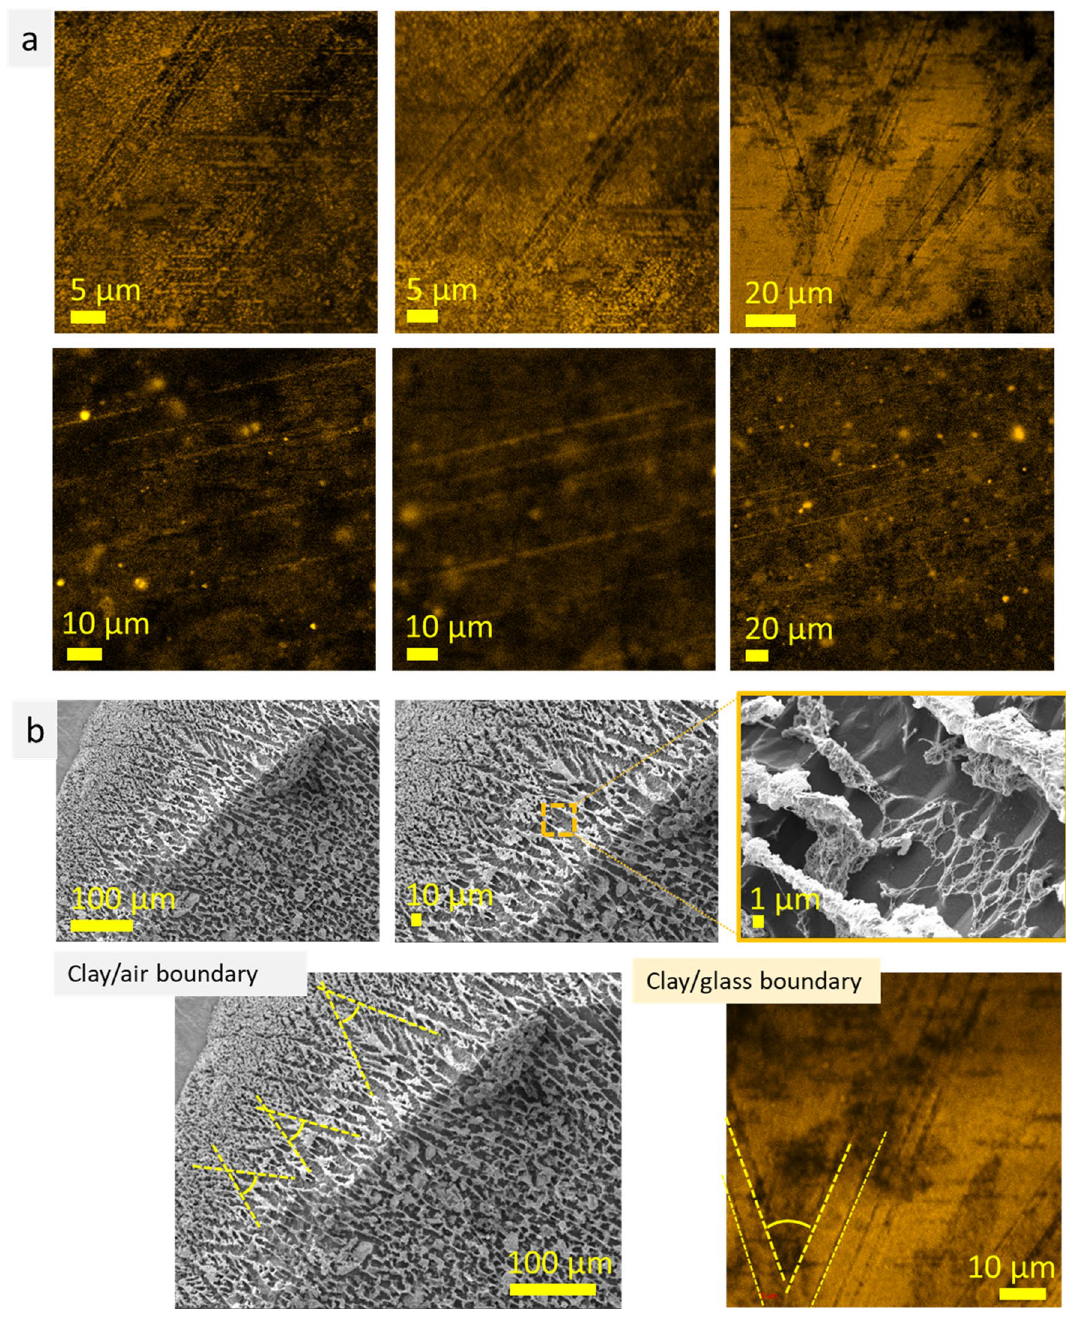
Figure 7. Confocal LSM images of montmorillonite clay with Atto 550 NHS ester (excitation wavelength 561 nm, laser power 0.012 mW, light—montmorillonite, dark—water) ( a ); cryo-SEM images of the surface (air/ clay boundary) of montmorillonite clay, bottom images show similarity (acute angles marked by dotted lines) between structures observed by cryo-SEM (left) and confocal LSM (right) techniques ( b ) on montmorillonite clay/air and montmorillonite clay/glass